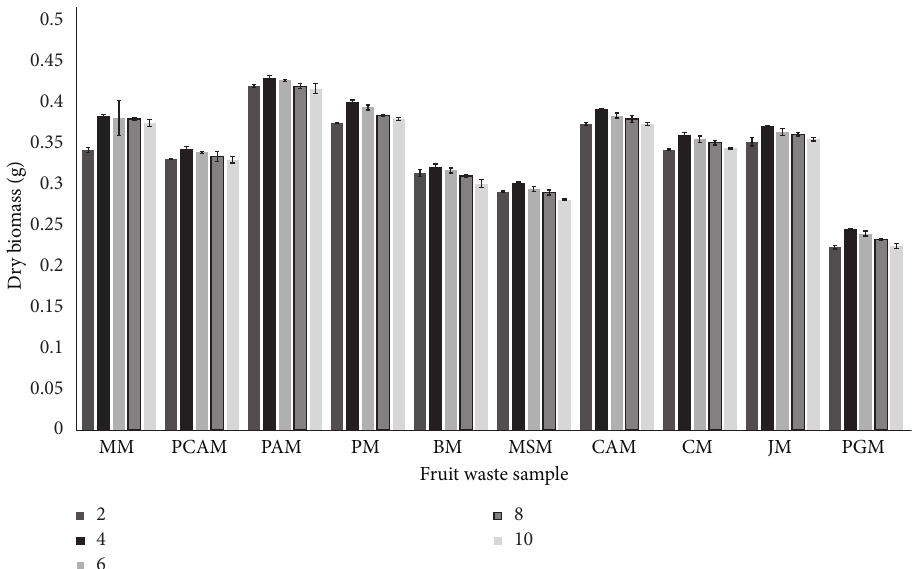
Figure 1: Dried biomass (g) of Bakers’ yeast yield, produced in the various fruit wastes media in submerged fermentation at 100rpm on a time course basis. Each data point represents the mean ± standard deviation ( n � 3, ∗ P ≤ 0 . 05).